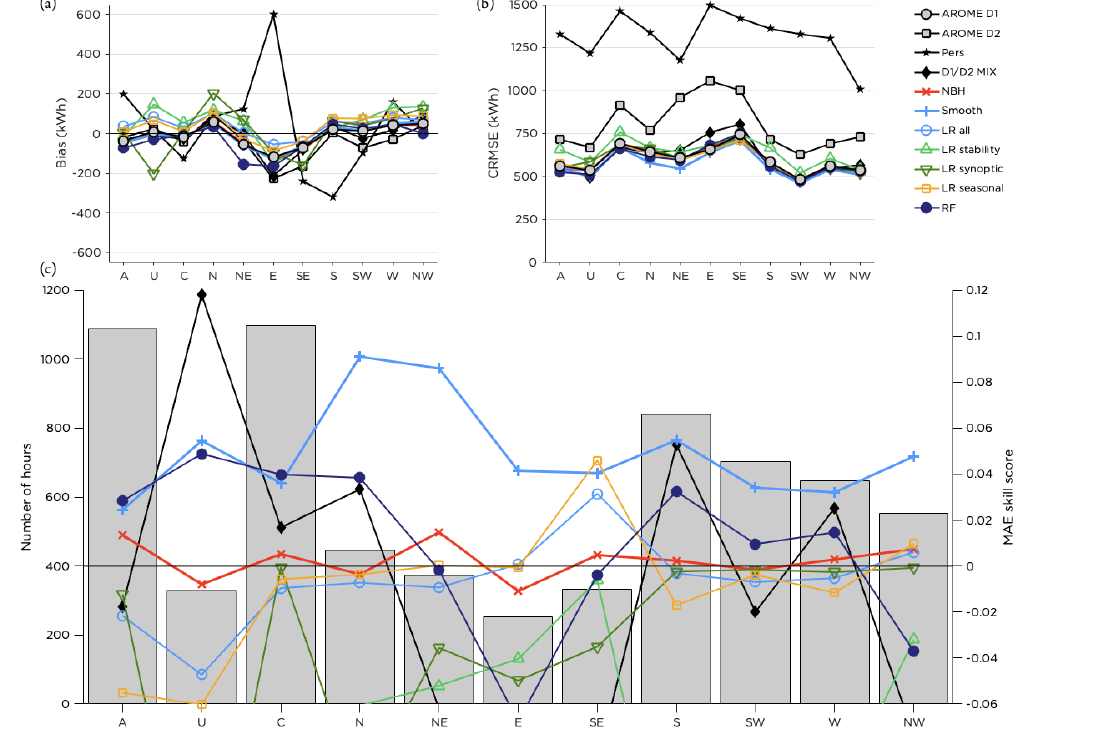
Figure 11. Performance of the post-processing methods for different LWTs. Panel (a) shows the bias, panel (b) the CRMSE and panel (c) the MAE skill score for the methods with the highest scores together with the distribution of the number of hours within each LWT during the test